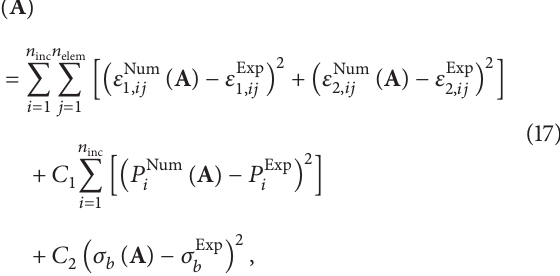
Figure 4: Schematic representation of the out-of-plane test devel- oped by Pottier et al.